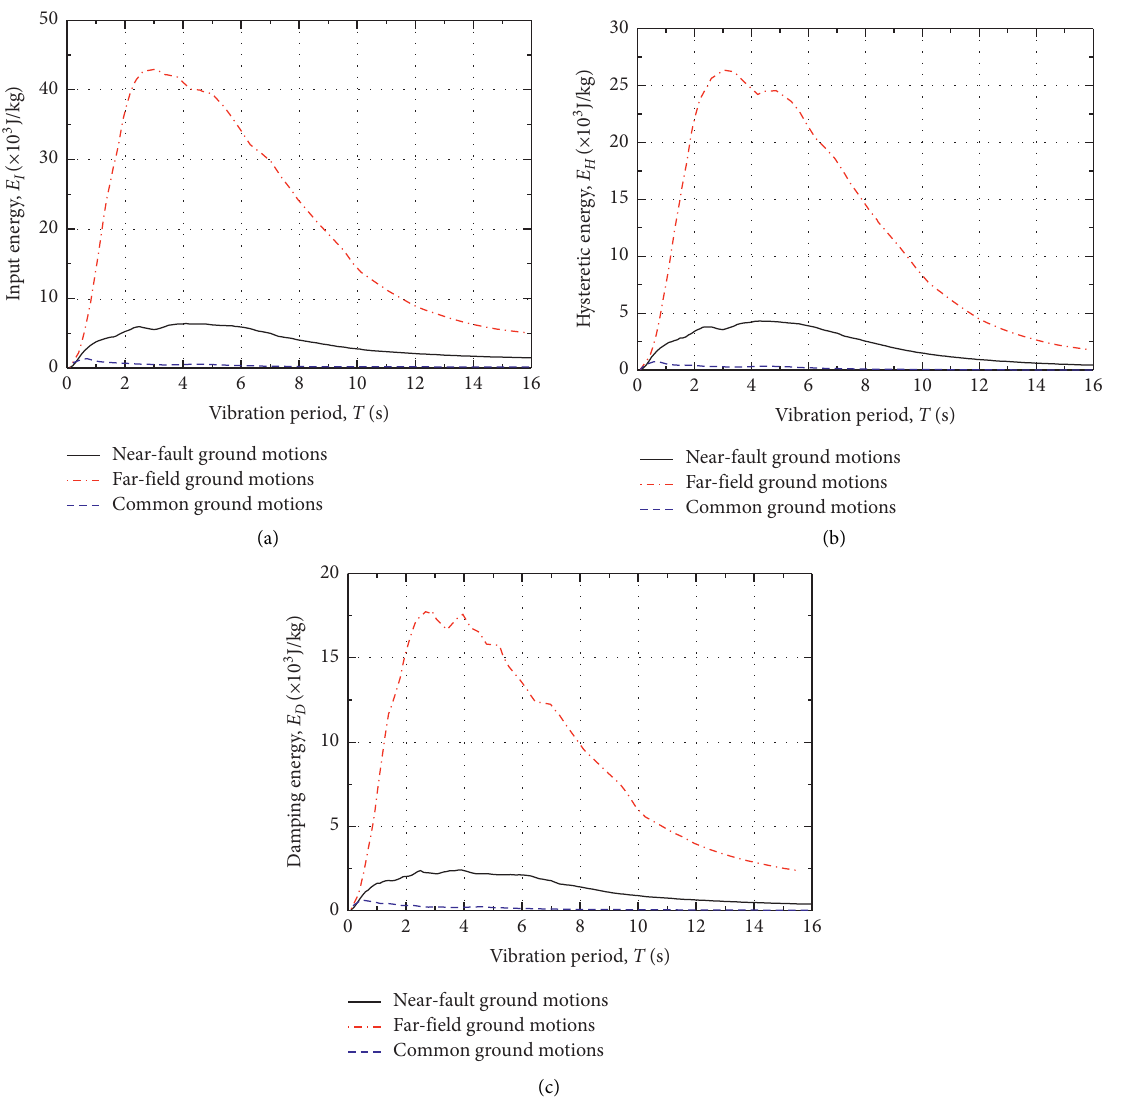
Figure 2: Energy response spectra. (a) Input energy. (b) Hysteretic energy. (c) Damping energy.